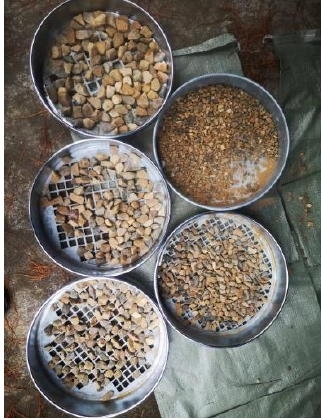
Figure 4. Aggregate classification results.